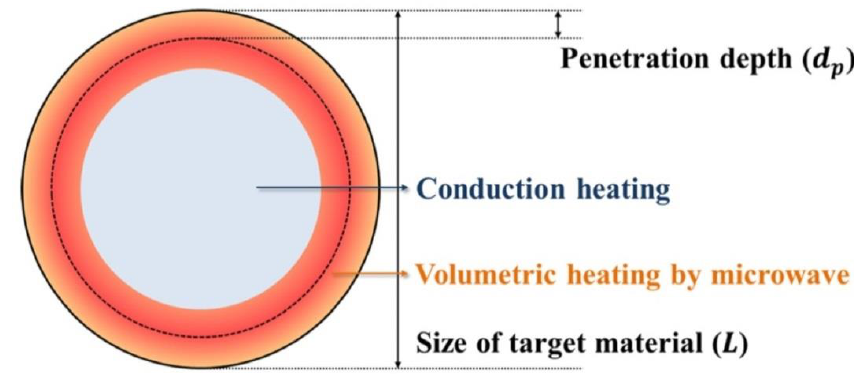
Figure 12. Schematic illustration of microwave heating phenomenon when the size of the target material is much larger than the microwave penetration depth. Reprinted with permission from [456], Copyright licenses / by-nc / 3.0 /